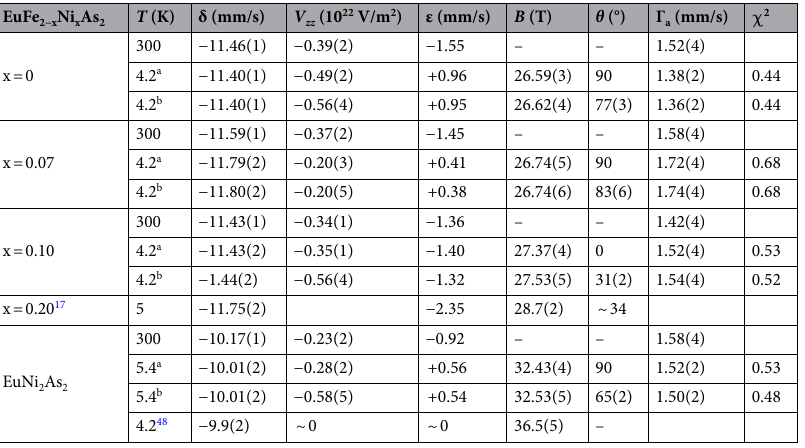
Table 1. The 151 Eu Mössbauer spectroscopy parameters for EuFe 2−x Ni x As 2 and EuNi 2 As 2 . The values for 4.2 K and 5.4 K with superscript "a" were obtained for spectra fitting with fixed angle θ , while superscript "b" corresponds to fitting with free angle θ . The values of respective parameter χ 2 are shown for comparison of the spectra fitting quality. Symbol Γ a stands for the absorber linewidth within transmission integral approximation, while the source linewidth Γ s = 0.72 mm/s was kept constant with a value close to the natural width Γ 0 = 0.655 mm/s. The meaning of the other symbols is described in the text. Figures 10 and 11 show spectra for 4.2 b K and 5.4 b K, respectively. Previous results from Ref. 17 and 48 are shown for comparison. Note that the angle θ is undefined in case of the V zz or B is equal zero.